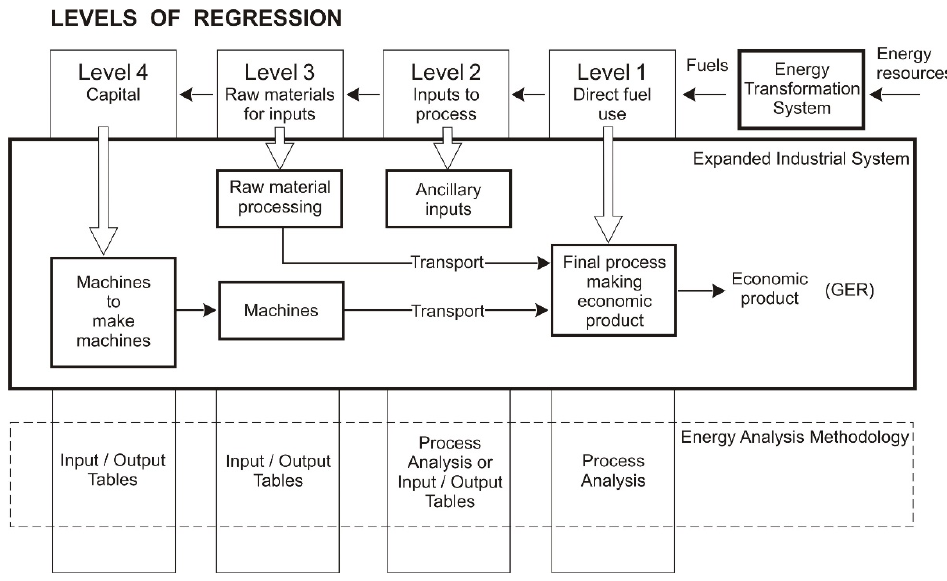
Figure 5. Schematic representation of the energy analysis process. Source: Hammond and Winnett [38]; adapted from Slesser [60]. Reprinted with permission from Ref. [38]. 2006, ICE Publishing.